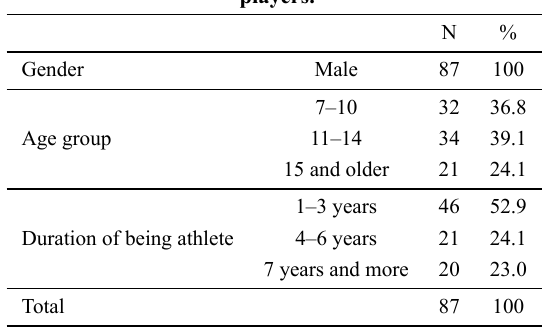
Table 1. Findings on demographic characteristics of chess